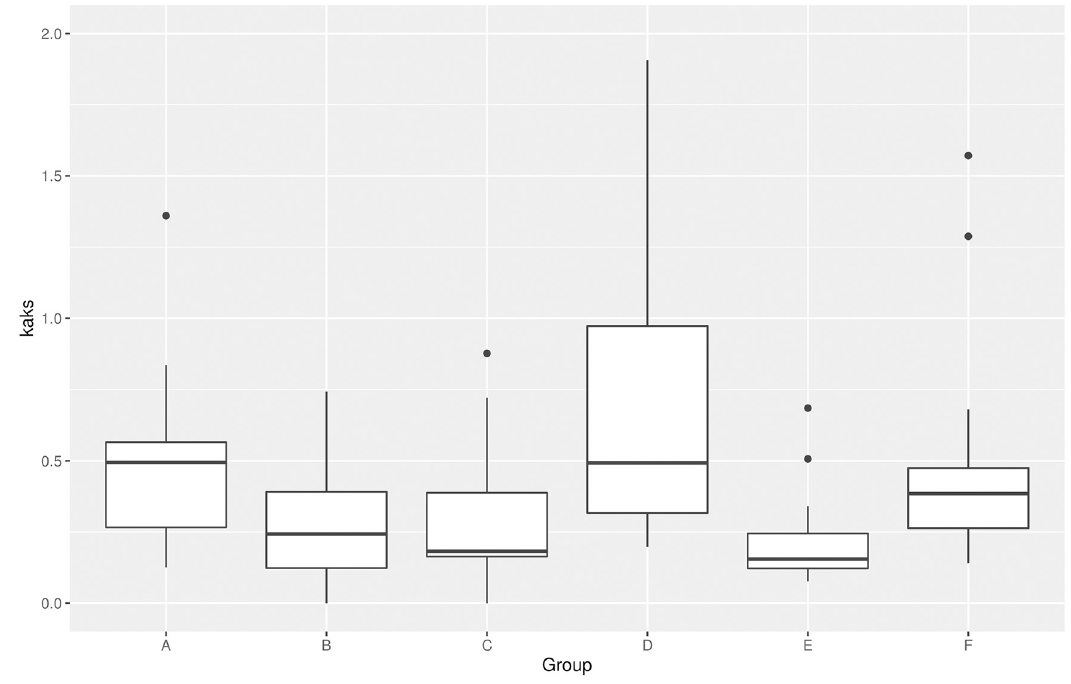
Fig 5. The Ka/Ks ratio of MIOX orthologous gene pairs of each